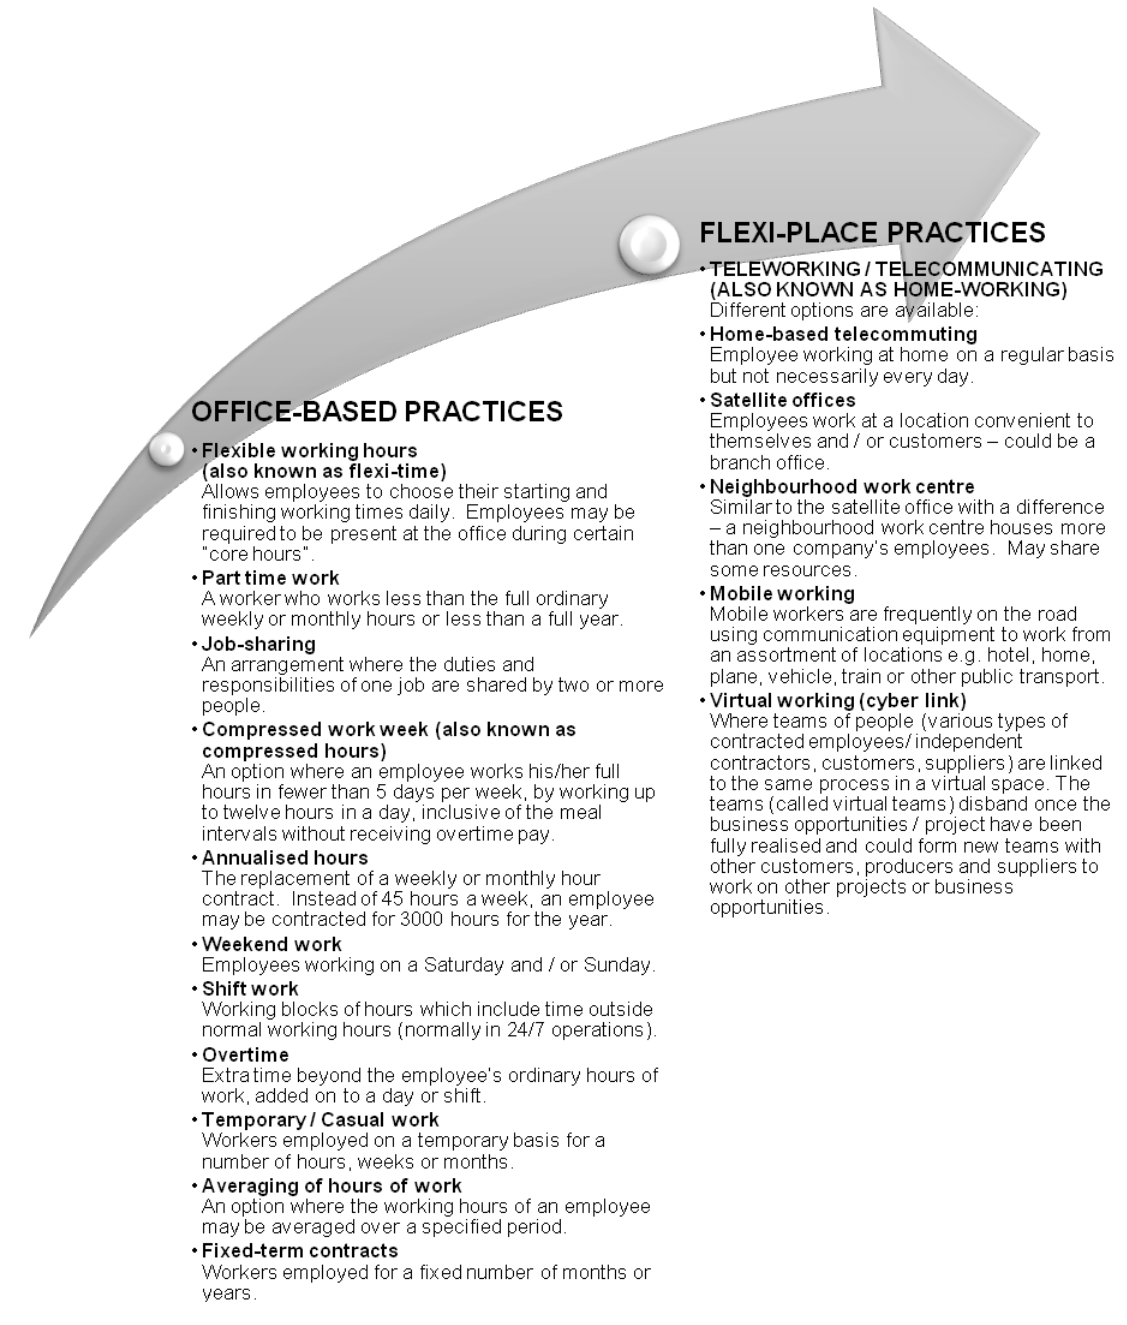
Table 1: Classification of flexible work